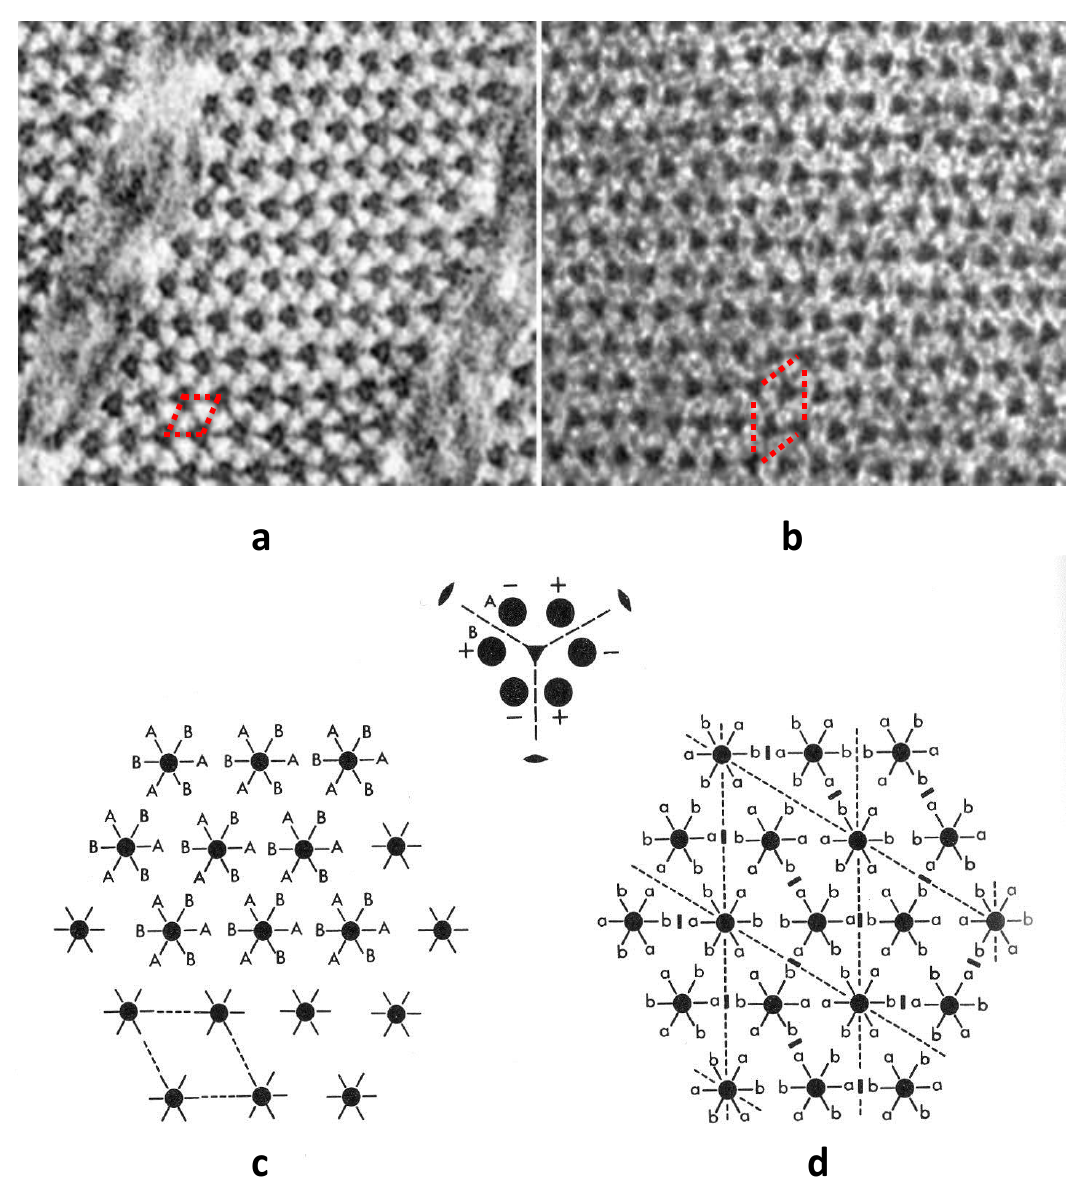
Figure 9. ( a , b ) Electron micrographs of muscle cross-sections close to the M-band, in ( a ) bony fish (plaice) ( b ) frog muscle. ( c , d ) M-band interactions using ( c ) unlike interactions (A to B); and ( d ) maximising like interactions (a to a and b to b); a superlattice is formed. (From [18], with permission from